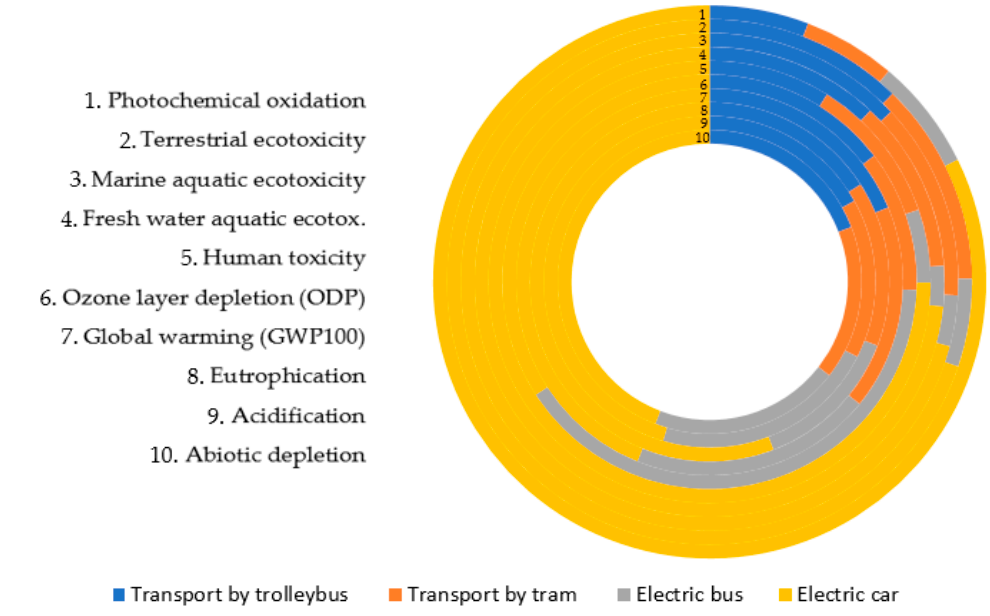
Figure 3. The results of characterizing the environmental impacts of electric cars.